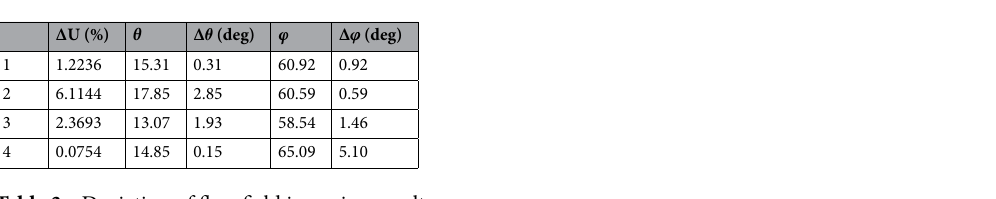
Table 3. Deviation of flow field inversion results.